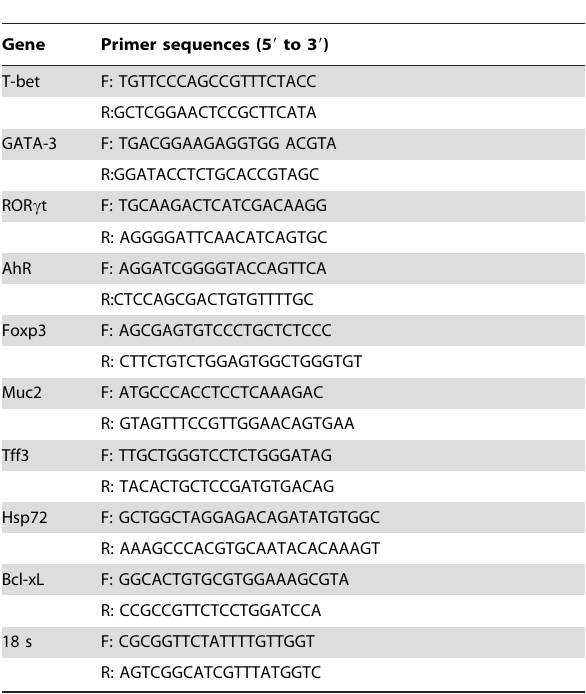
Table 2. Sequences of oligonucleotide primers used in the PCR